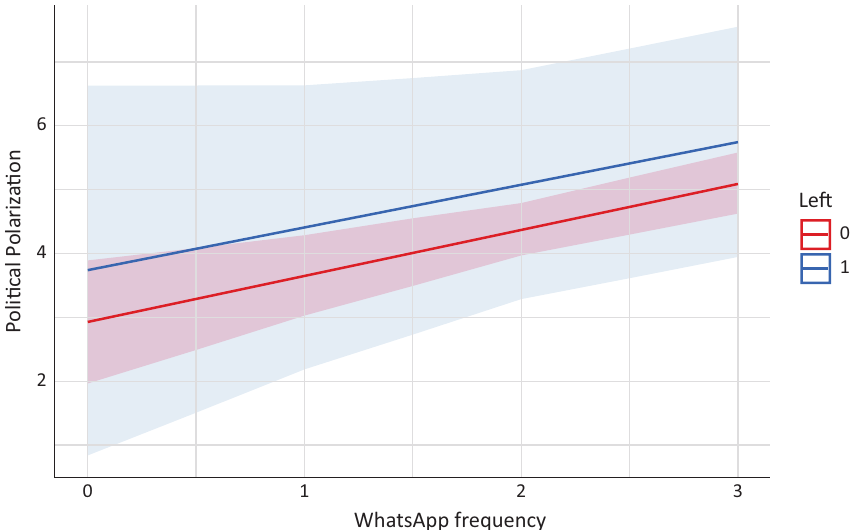
Figure 3. Predicted values of perceived political polarization in Colombia according to WhatsApp usage frequency and political position